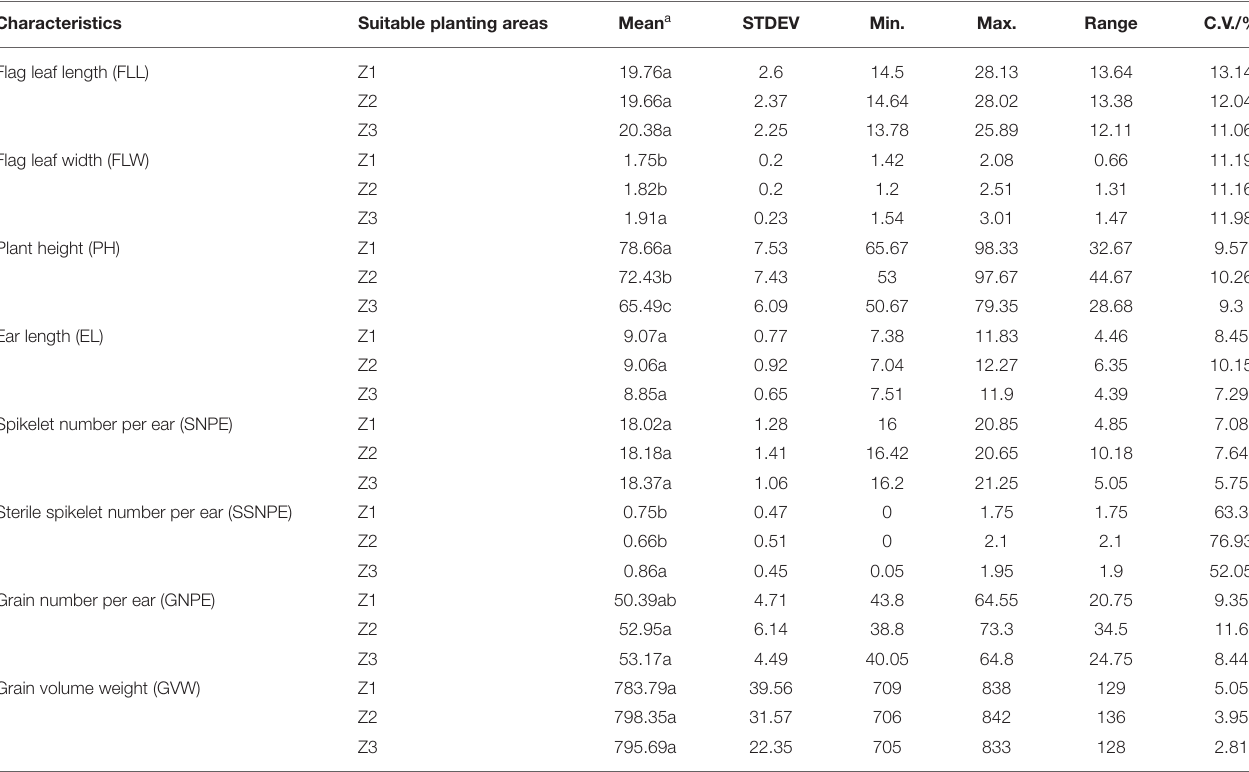
TABLE 2 | Statistical analysis results of eight measured characteristics of 195 wheat varieties.